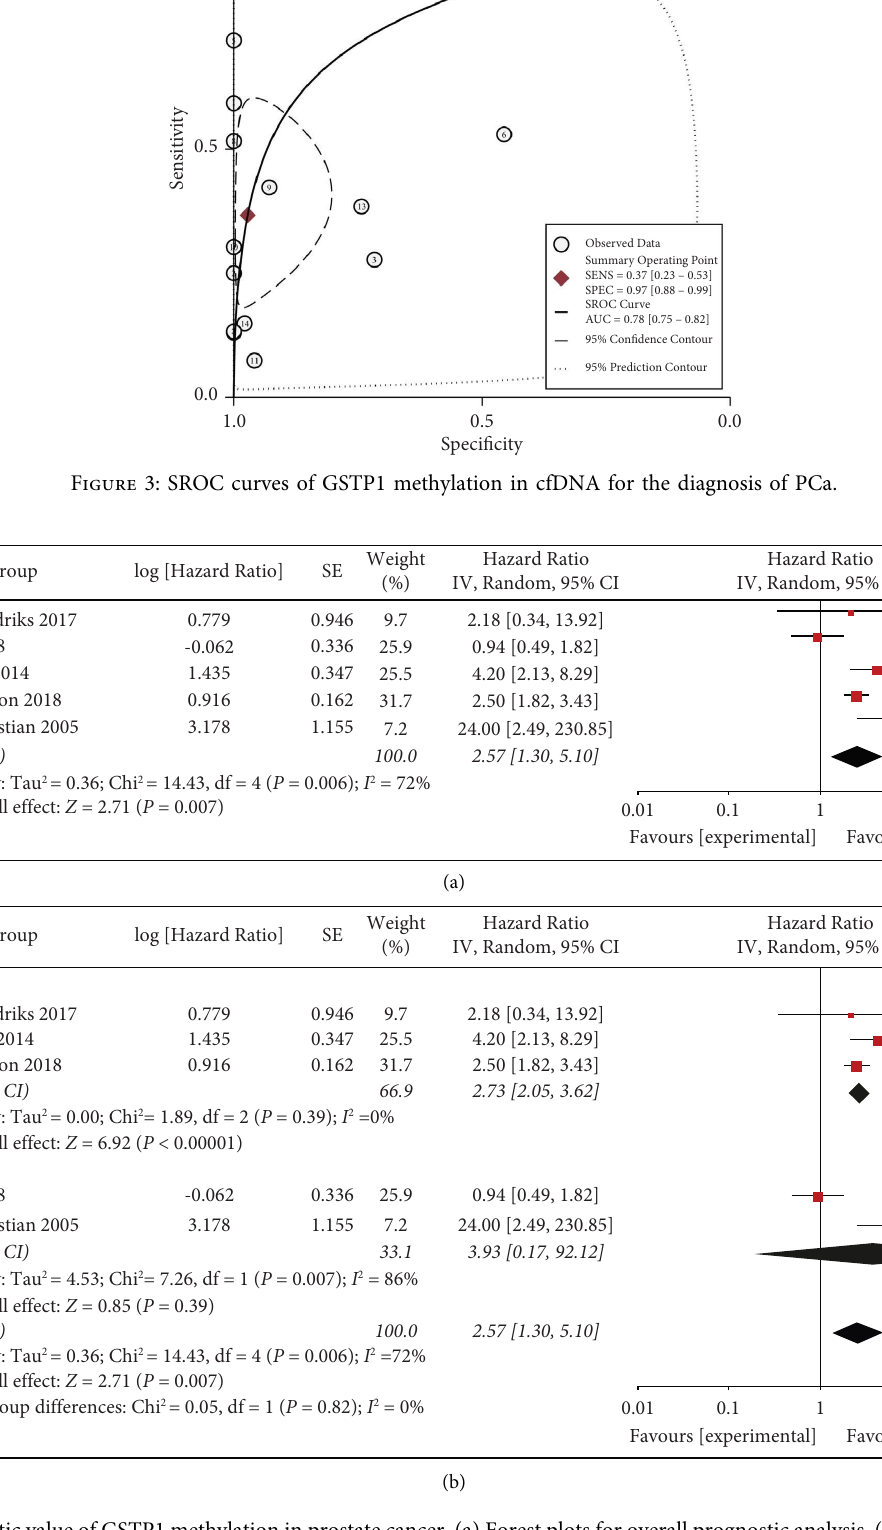
Figure 4: Prognostic value of GSTP1 methylation in prostate cancer. (a) Forest plots for overall prognostic analysis. (b) Forest plots for the survival index analysis